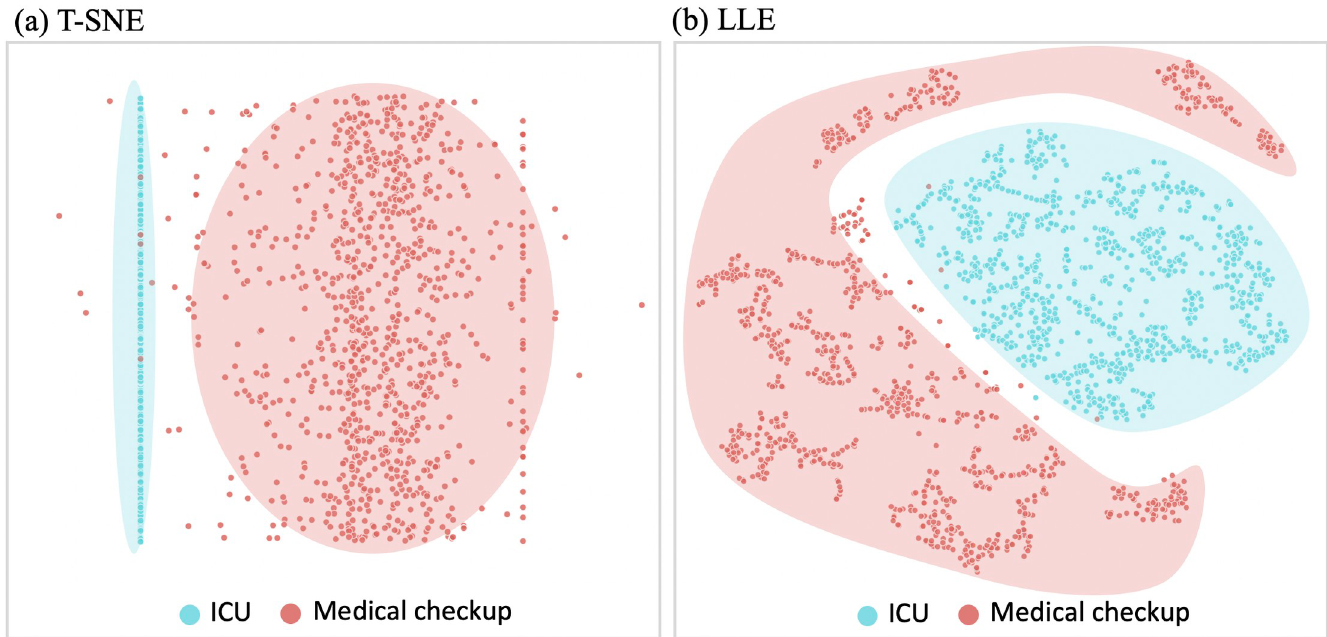
Fig 3. Visualization of (a) t-SNE and (b) LLE in two-dimensional space for ECG from ICU and Healthy test. ECGs from ICU are shown as blue clusters while ECGs from medical-checkup are shown as red clusters. It shows that feature vectors can represent the differences between healthy and unhealthy people although the model was trained without any